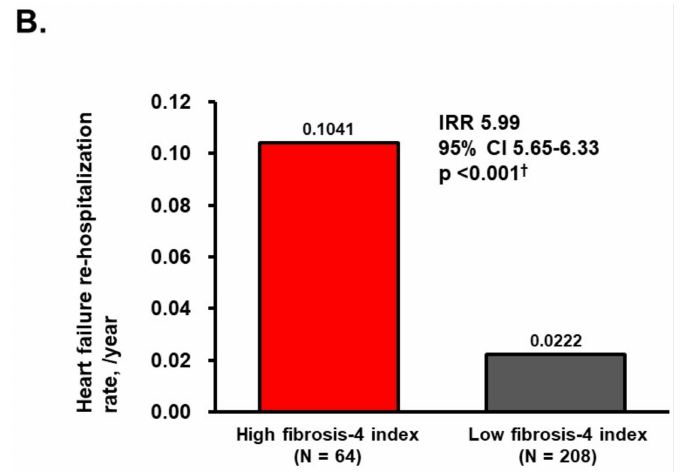
Figure 3. Cumulative incidence of the primary endpoint accounting for death as a competing risk ( A ) and event rates of the primary endpoint ( B ) stratified by the fibrosis-4 index levels. IRR, incidence rate ratio; CI, confidence interval. * p < 0.05 by log-rank test. † p < 0.05 by negative binomial regression analysis.